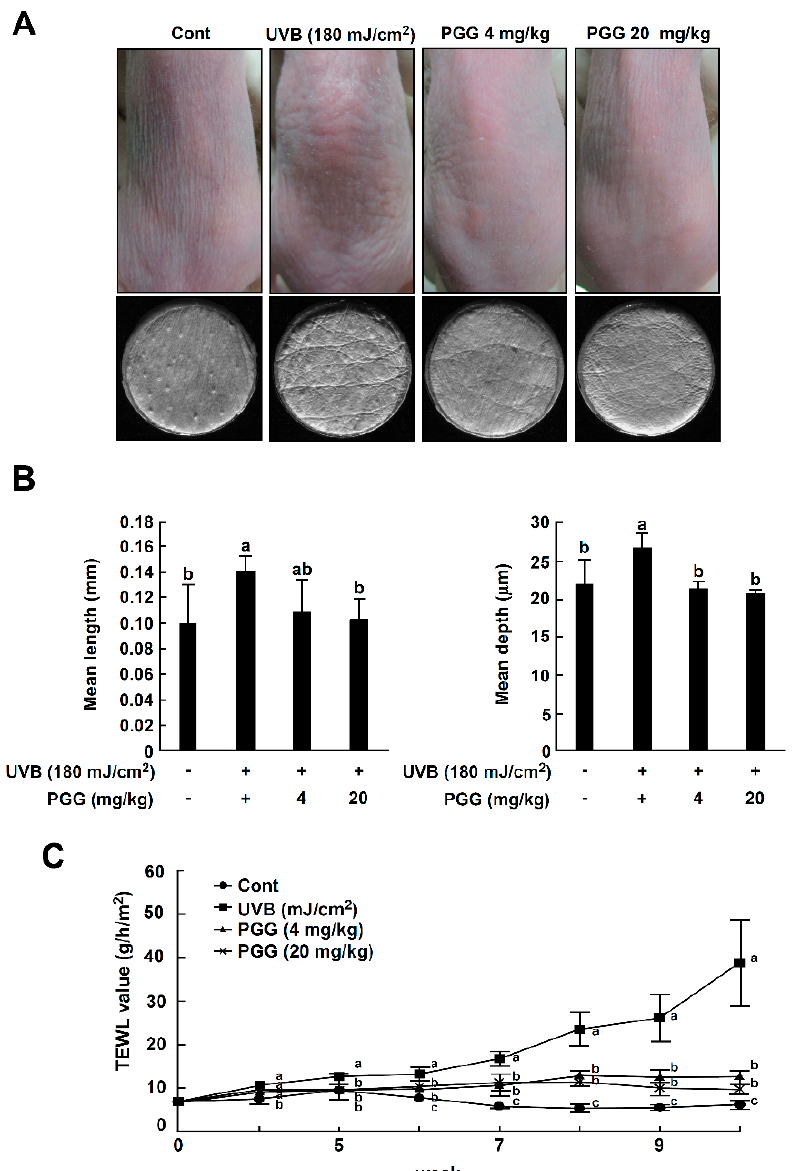
Figure 5. E ff ect of PGG on UVB-induced photoaging symptoms in SKH-1 hairless mice. ( A ) Anti-photoaging e ff ect of PGG on visual wrinkle formation by UVB irradiation in SKH-1 hairless mice. ( B ) Analysis of replicas for the e ff ect of PGG on UVB-induced mean length and depth of skin wrinkles. ( C ) Changes in TEWL of SKH-1 hairless mice dorsal skin during the experimental period. Results are shown as the means ± S.D. ( n = 5). Values that do not share common letter (a,b,c) on bar indicate statistically significant di ff erence from each other ( p < 0.05).